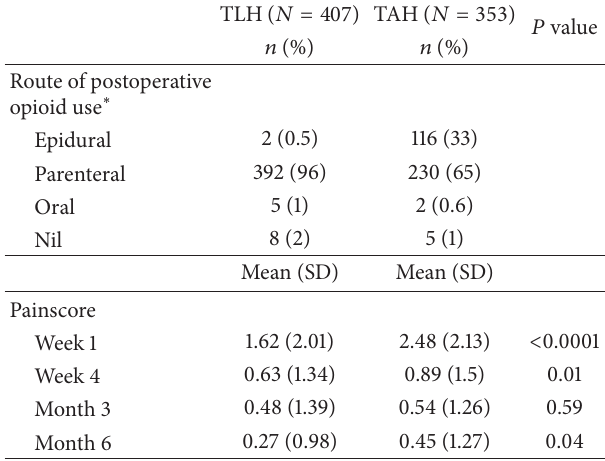
Table 2: Opioid use ≤ 2 days after